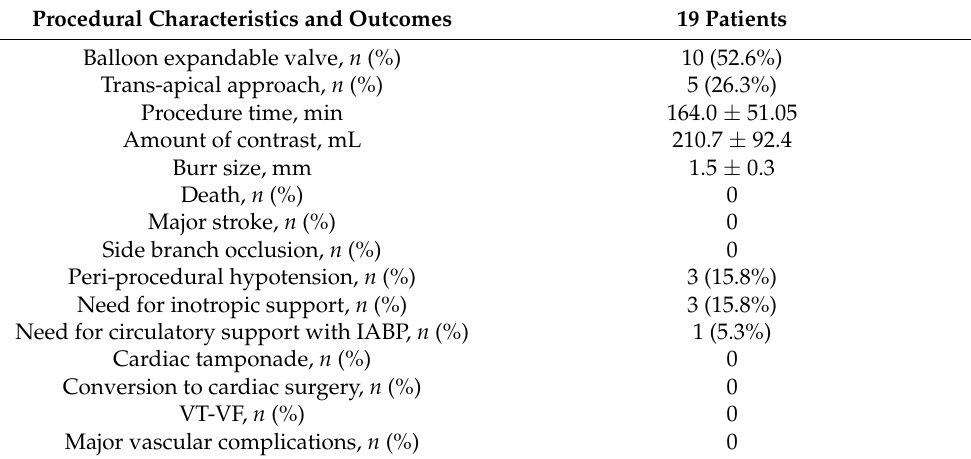
Table 2. Procedural characteristics and